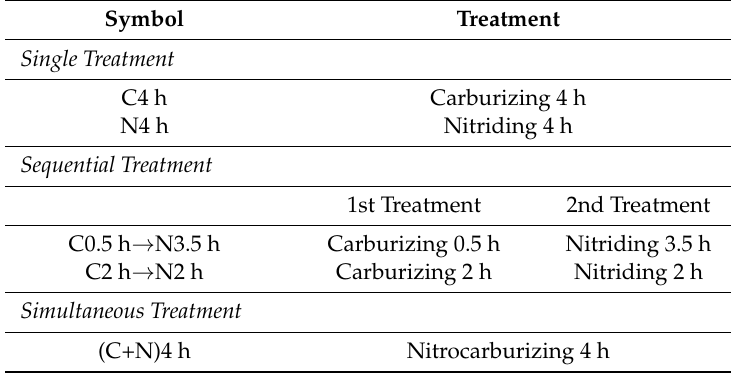
Table 1. Conditions of low-temperature plasma treatments at 400, 425 and 450 ◦